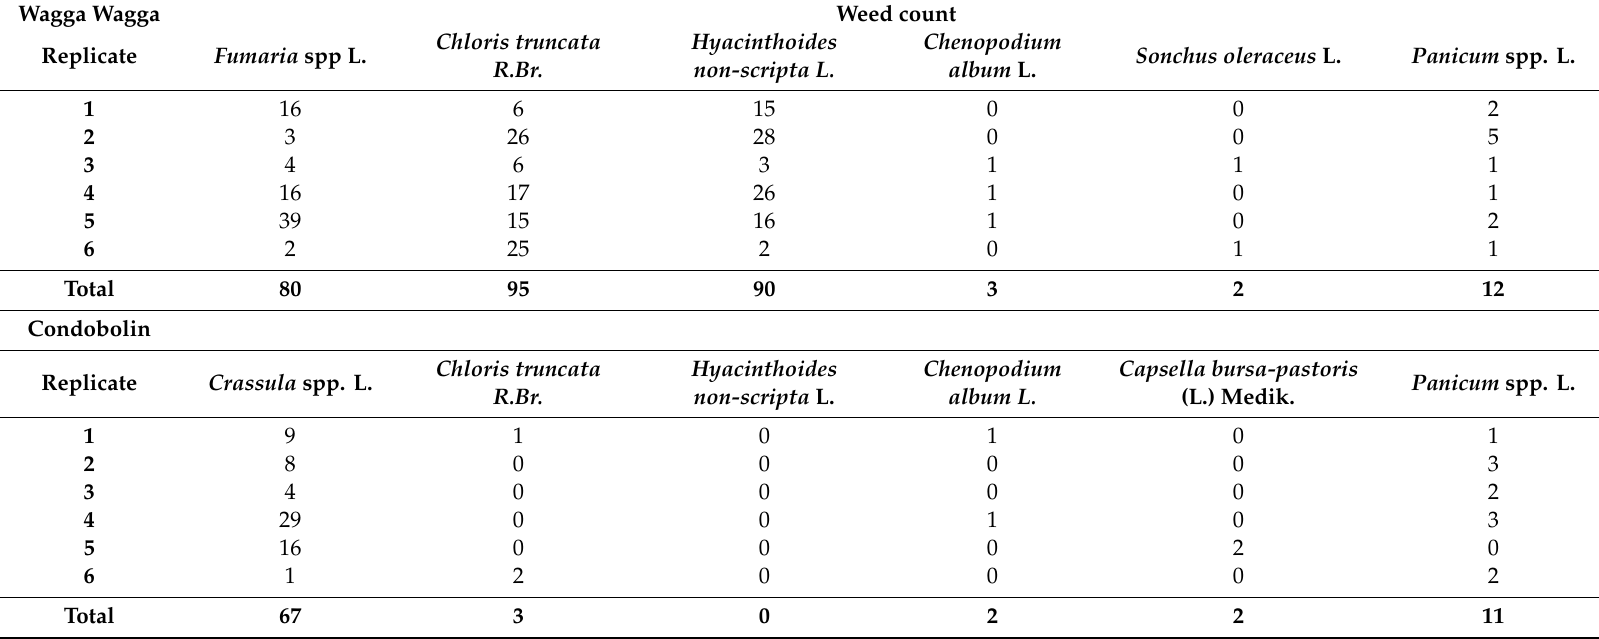
Table 3. The total glasshouse seedbank weed species germination density (seedlings / m 2 ) generated in the topsoil from Condobolin and Wagga Wagga trial sites taken at crop sowing in 2015 and 16 (based on four